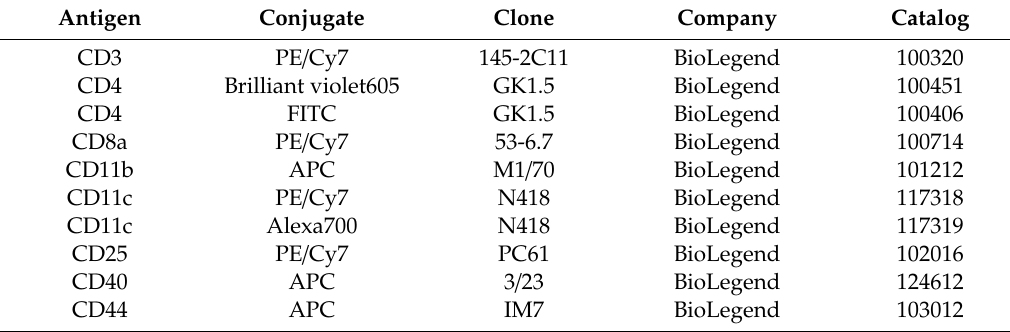
Table 2. FACS antibodies used in this